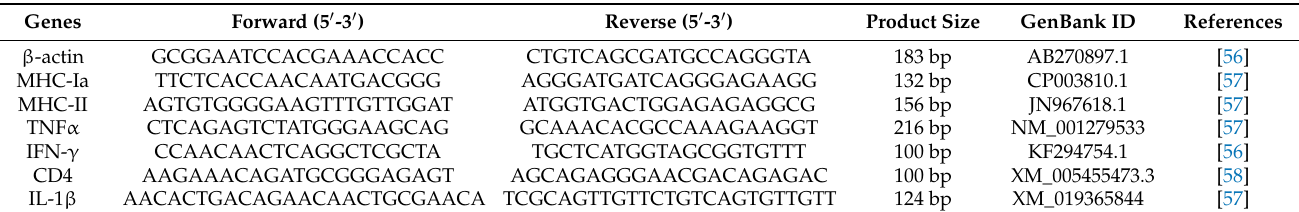
Table 2. Genes and primer sequences used in the qRT-PCR